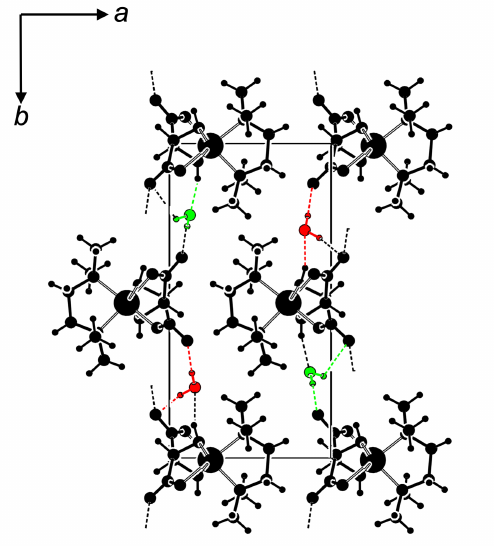
Figure 4. Hydrogen bonds in 2a (PLATON, [50]); [Cu( D -H 2 tart)(TMEDA)] n chains are shown in black, co-crystallized water molecules in green and